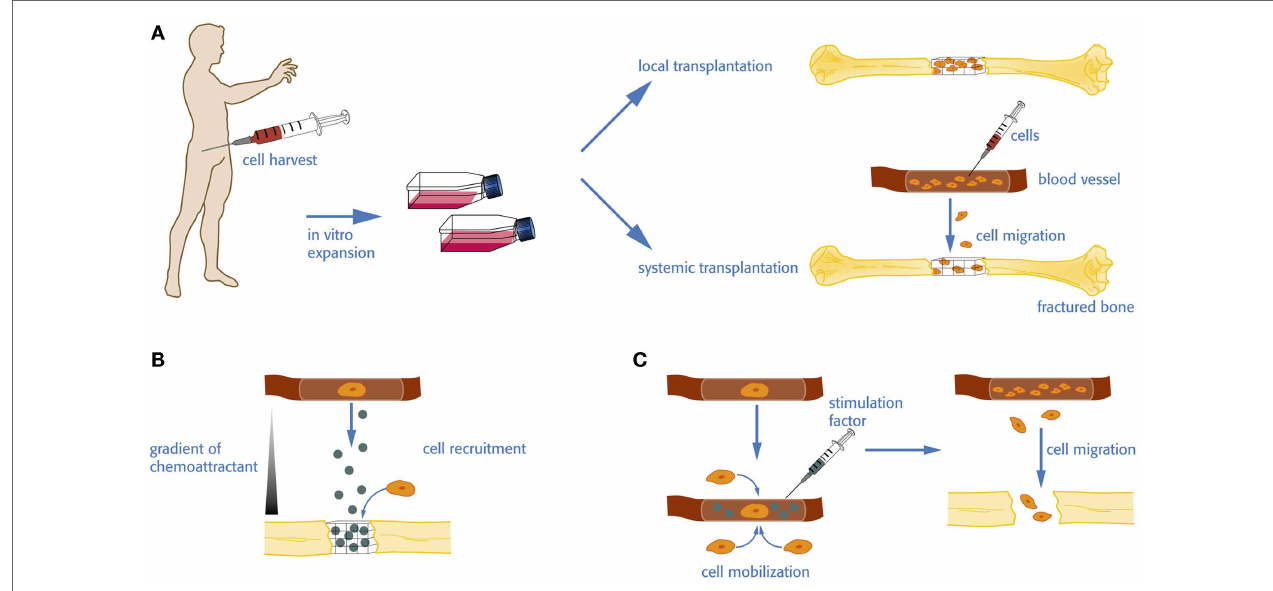
to the defect site. (b) Homing factors are directly delivered to the defect site. The release and diffusion of the factor create a gradient subsequently attracting stem and progenitor cells from the local tissue environment or the circulation. (C) Native stem and progenitor cells may be mobilized into the circulation by the administration of a stimulation factor enhancing the level of available